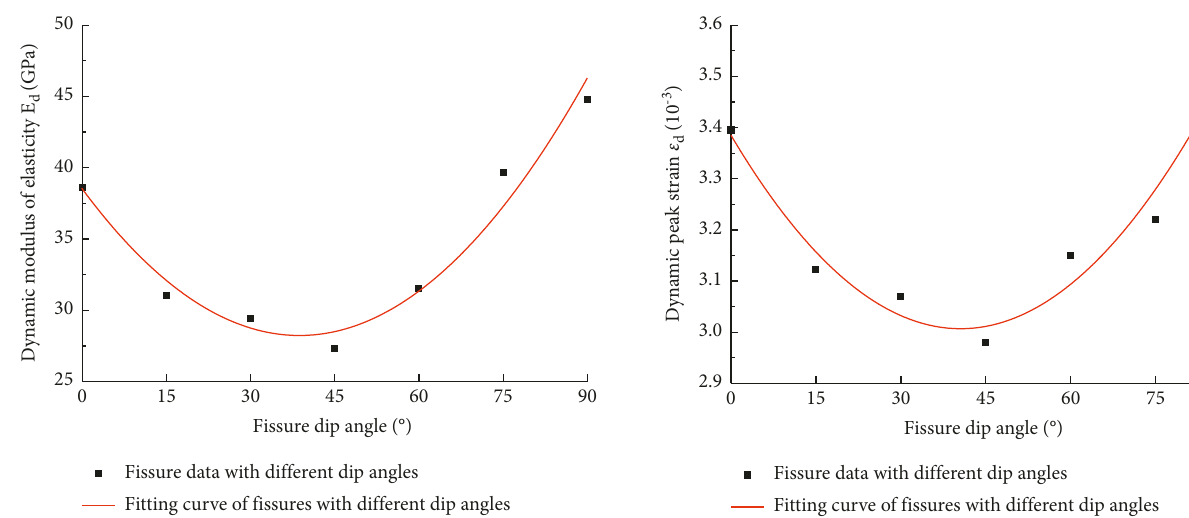
Figure 6: Relationship between the fissure angle and dynamic elastic modulus.